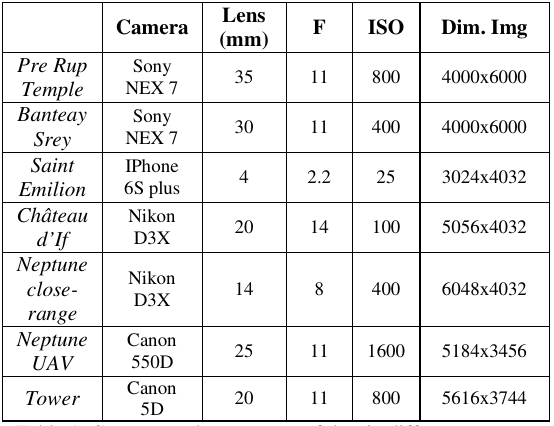
Figure 4. The Temple of Neptune – Paestum